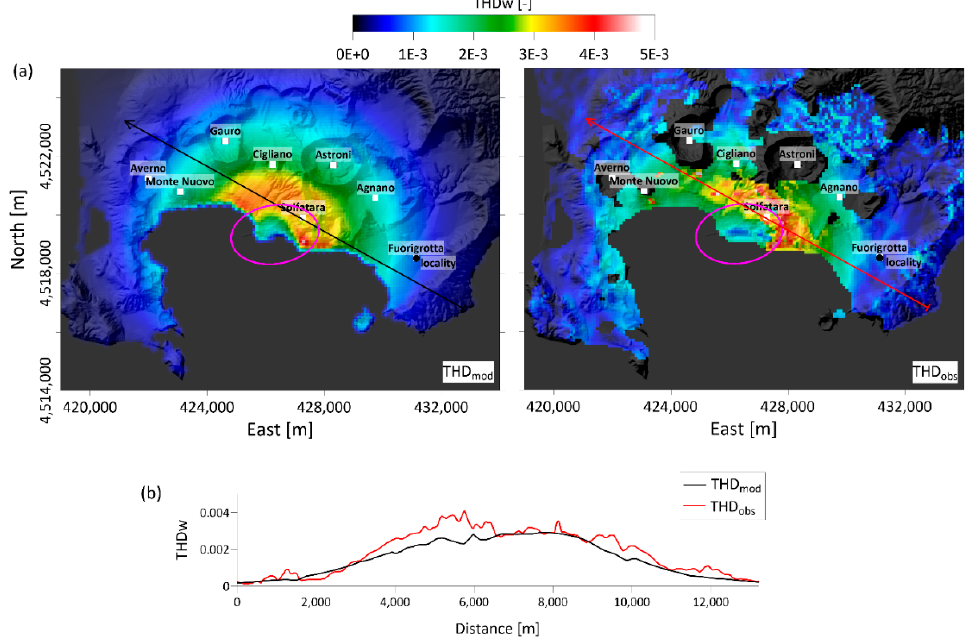
Figure 6. Stationary FE model results. ( a ) THD mod results calculated for the modeled vertical velocity deformation field (left) and for data THD obs (right) (see Figure 4 in [15]). The magenta ellipse is the retrieved source projection on the map. The results are superimposed on the SRTM DEM of the area. ( b ) THD profiles from ( a ).